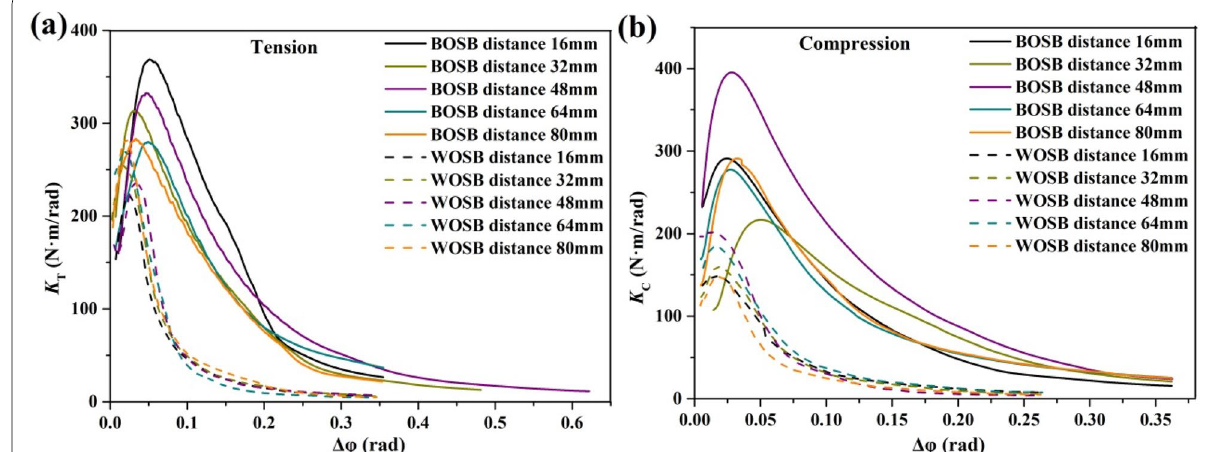
Fig. 8 Variation of stiffness coefficient K (N m/rad) in the function of the rotation angle Δ φ (rad) of joint: a compression, b tension ·